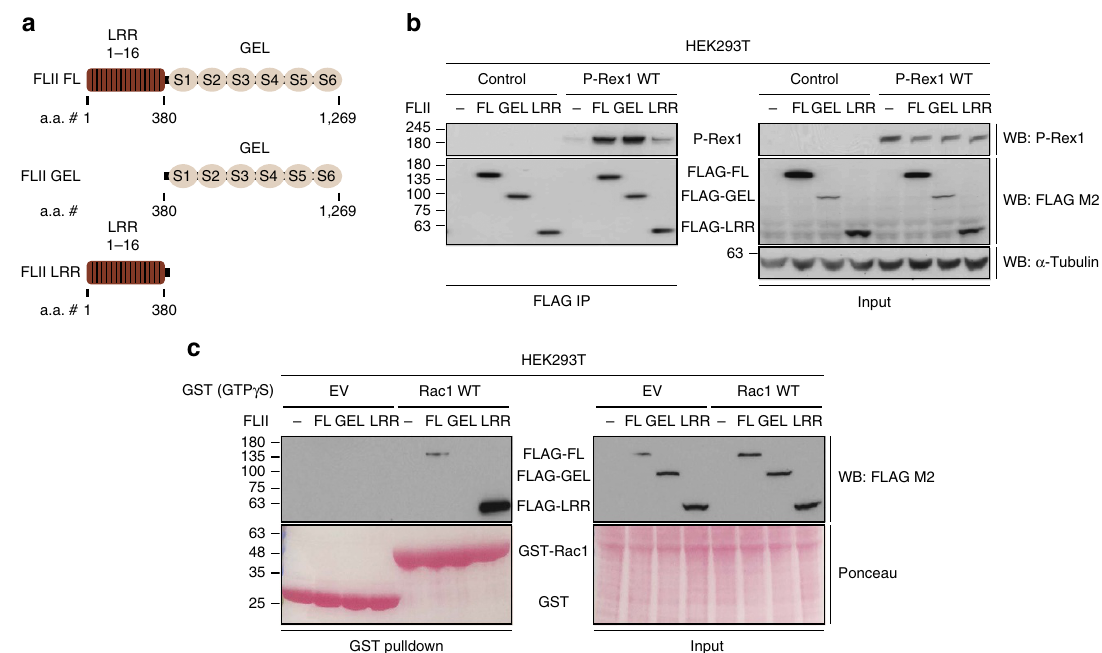
Figure 5 | P-Rex1 and Rac1 bind preferentially to the GEL and LRR domain of FLII, respectively. ( a ) Schematic representation of FLII domain structure showing 16 leucine-rich repeats (LRR) comprising the N-terminal LRR domain and six gelsolin-like repeats (S1-S6) representing the C-terminal GEL domain together with the amino acid number (a.a. #) range for each domain. FLII FL, full-length FLII; FLII GEL, gelsolin domain only; FLII LRR, LRR domain only. ( b ) FLAG immunoprecipitation (IP) from HEK293Tcells expressing the different FLAG-tagged FLII domain mutants outlined in a alone or together with P-Rex1 WT. Co-precipitated exogenous P-Rex1 was detected by western blot analysis. a -Tubulin was used as a loading control. Representative western blot from three independent experiments. ( c ) GST pulldown using purified GST (EV) or GST-tagged Rac1 WT (Rac1 WT) loaded with GTP g S and incubated with HEK293T lysates expressing the different FLAG-tagged FLII domain mutants outlined in a . Co-precipitated FLAG-tagged FLII domain mutants were detected by western blot analysis. Ponceau staining was used as a loading control. Representative western blot from three independent